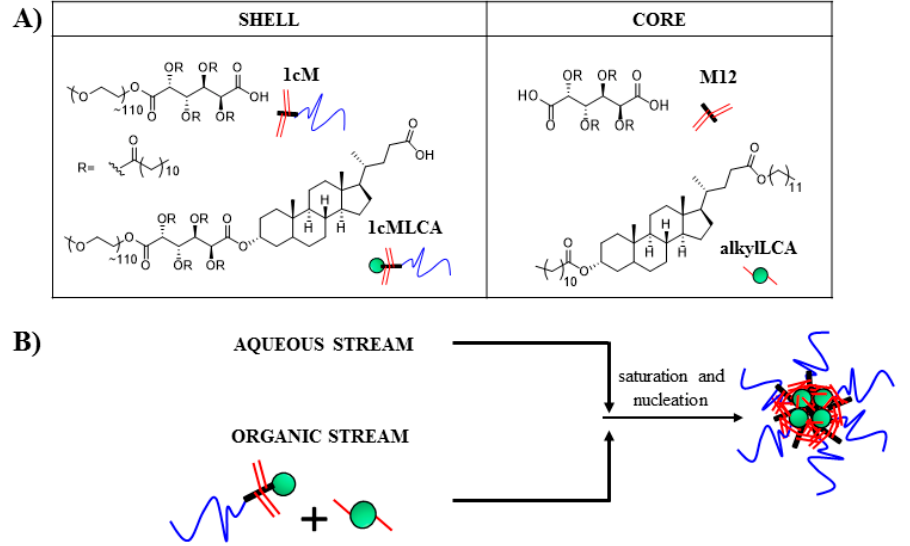
Figure 1. Chemical structures and schematics of shell and core molecules incorporated into NPs via flash nanoprecipitation. Chemical structures of 1cM and 1cMLCA shells and M12 and alkylLCA cores and corresponding cartoons ( A ). R group refers to dodecyl ester (top left) in all chemical structures. Schematic representation of the flash nanoprecipitation technique utilized to generate amphiphilic scorpion-like macromolecule (AScM) nanoparticles (NPs) using 1cMLCA[alkylLCA] as an example ( B ) where the poly(ethylene glycol) (PEG) components (blue lines) extend into aqueous media from the shell and lithocholic acid (LCA) (green circles) is encapsulated within the core of the NP. Nomenclature of 1cM refers to 1 carboxylic acid (1c) on a mucic acid backbone (M), and M12 nomenclature refers to a mucic acid backbone (M) with dodecyl alkyl chains (12).